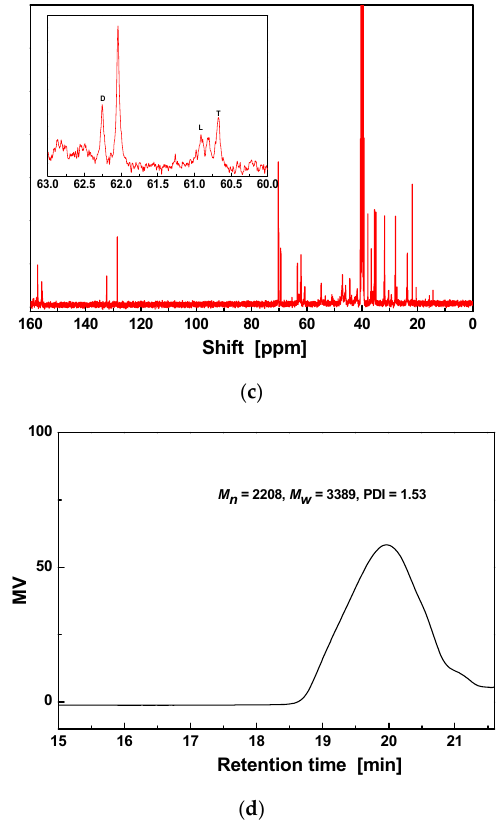
Figure 1. Characterization of FHBPUA. ( a ) Fourier transform infrared spectroscopy; ( b ) 1 H nuclear magnetic resonance; ( c ) 13 C nuclear magnetic resonance and ( d ) Gel permeation chromatography.